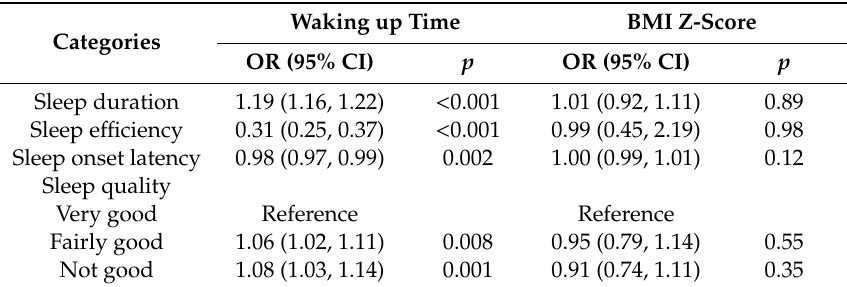
Table 6. Baseline relationships between waking ( n =